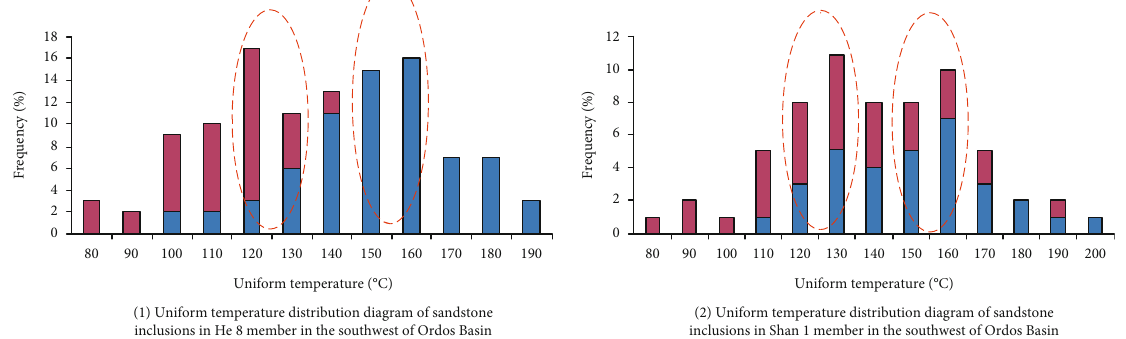
Figure 8: Comparison of gas-phase CO section sandstone reservoir in the study area.